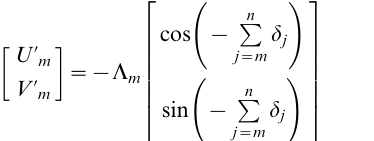
Figure 3. The effect of noise in different neural representations of space during PI. Note that each complete path is shown in representational space for clarity, but the process of PI only requires the maintenance of the current net position, ignoring previous steps. The examples shown are ( A ) allocentric dynamic vectorial representation (ADVR) e.g. allocentric polar (AP), ( B ) egocentric dynamic vectorial representation (EDVR) e.g. egocentric polar (EP), ( C ) allocentric static vectorial representation (ASVR) e.g. allocentric Cartesian (AC) and ( D ) egocentric static vectorial representation (ESVR) e.g. egocentric Cartesian (EC). Input rotational errors are denoted d , update errors are denoted e , and representational step lengths are denoted L . Actual locomotion is represented by three gray arrows in an allocentric (A and C) or egocentric (B and D) reference frame. The thick pink arrows represent distances, and egocentric forward ( F ), left ( L ) and right ( R ) are labelled for clarity. Other conventions are as in previous figures. See text for